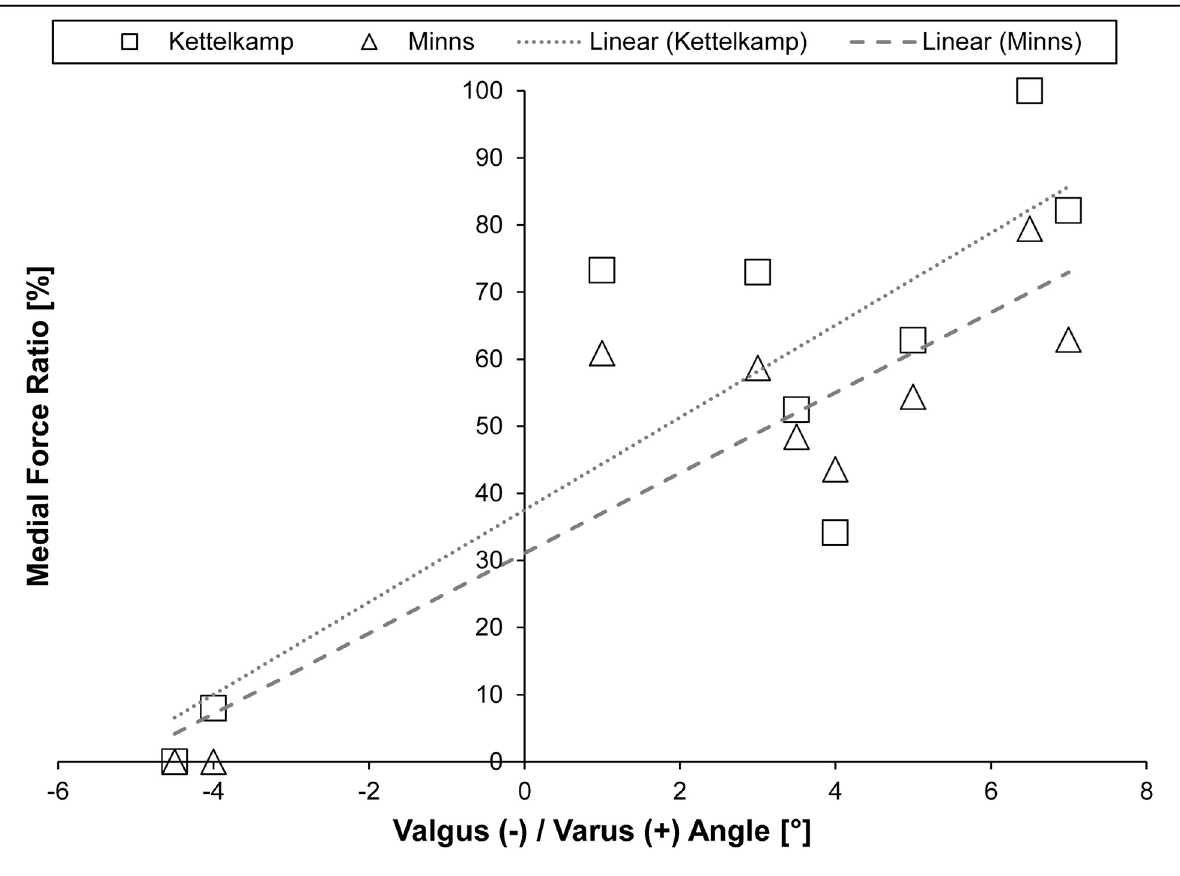
Fig 6. Correlation and regression analysis between tibiofemoral angle and medial force ratio during static two-leg stance based on the models of Kettelkamp and Minns.